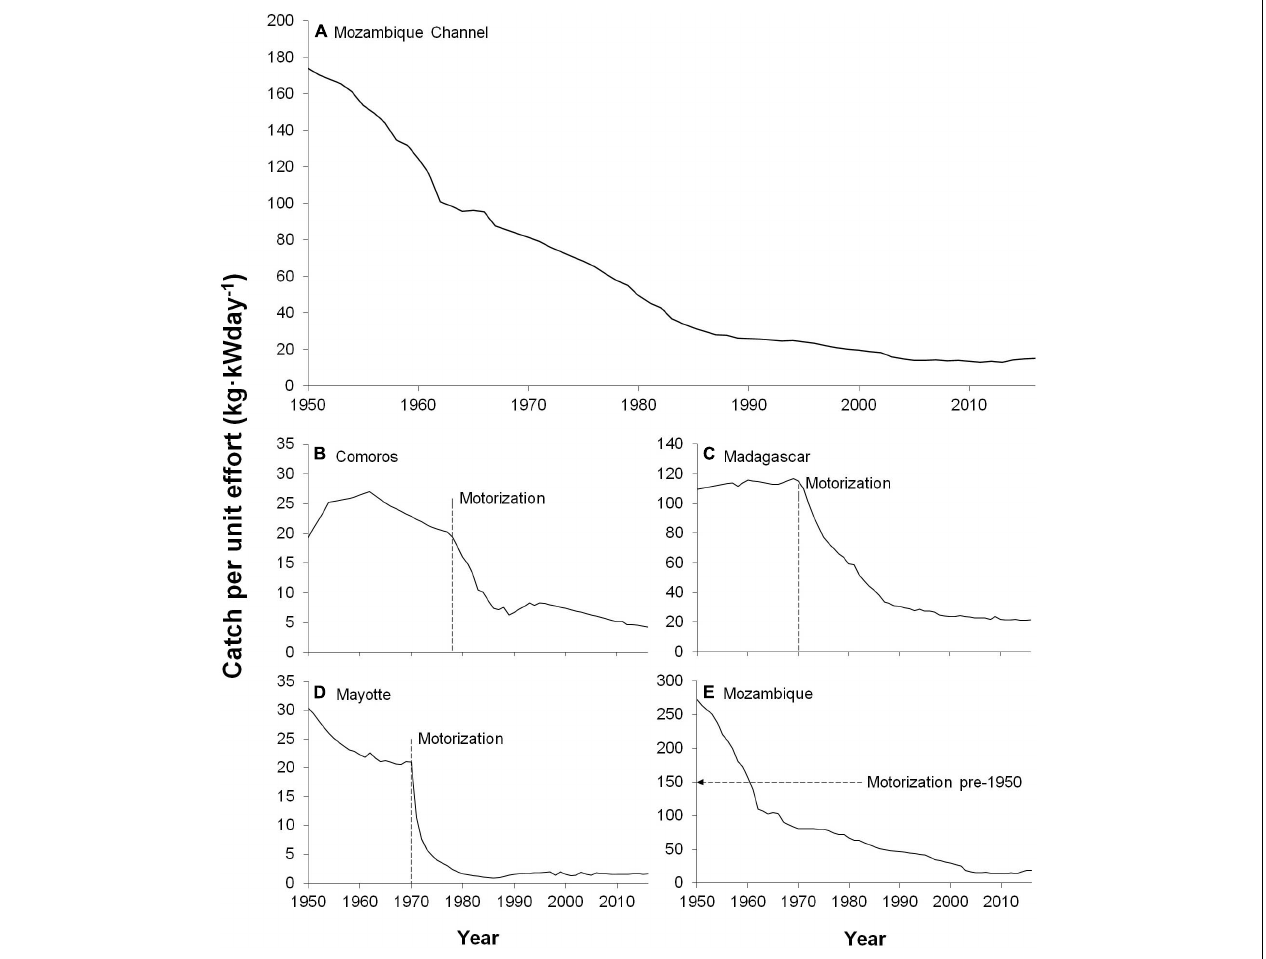
FIGURE 4 | The catch per unit effort (CPUE) for small-scale fisheries (kg · kWday - 1 ) from 1950 to 2016 for (A) the complete Mozambique Channel region; (B) Comoros; (C) Madagascar; (D) Mayotte; and (E) Mozambique. Start year of motorization is indicated.